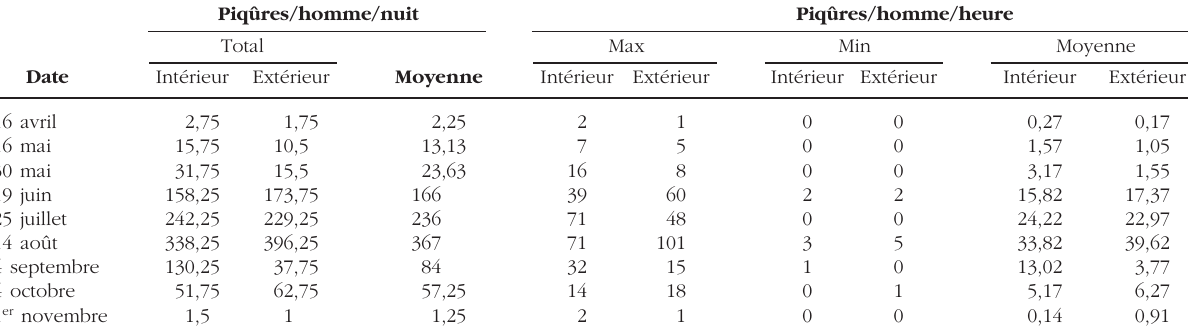
Tableau I. – Variation de la densité agressive d’ An. labranchiae à Larache, 2007.